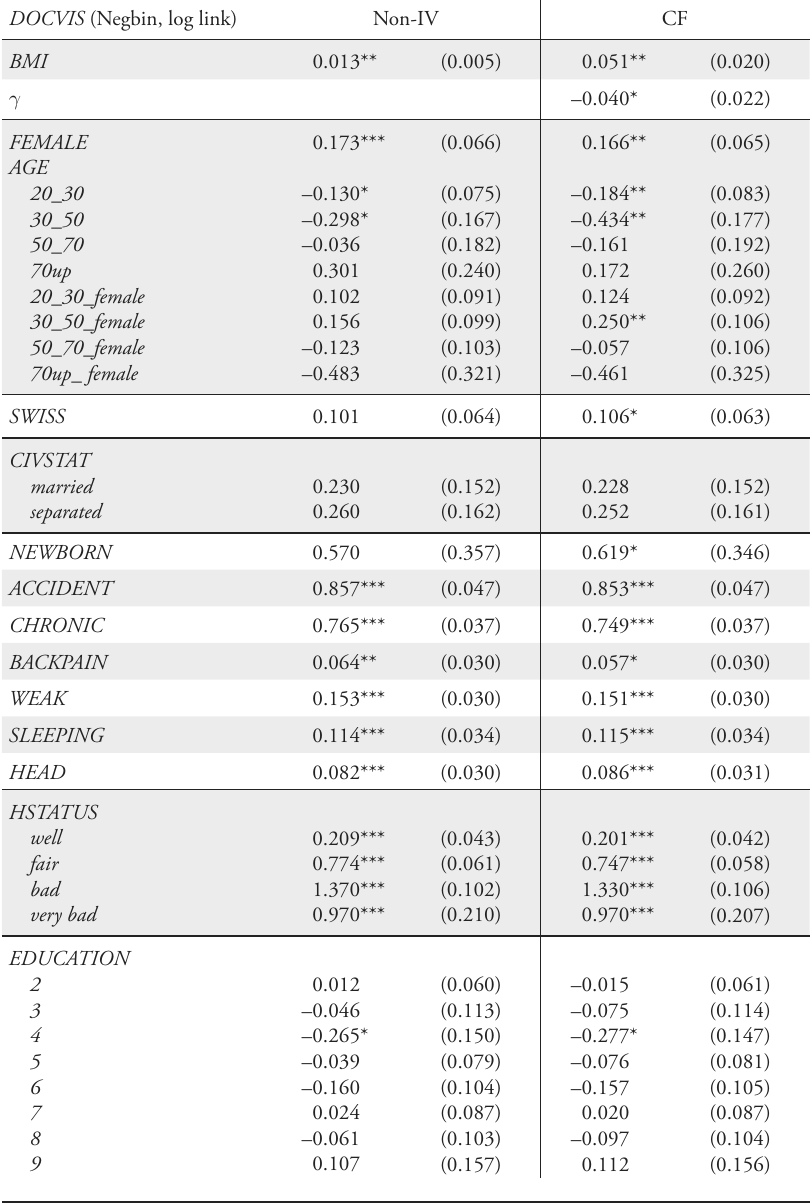
Table 9: Complete Output from the Outpatient